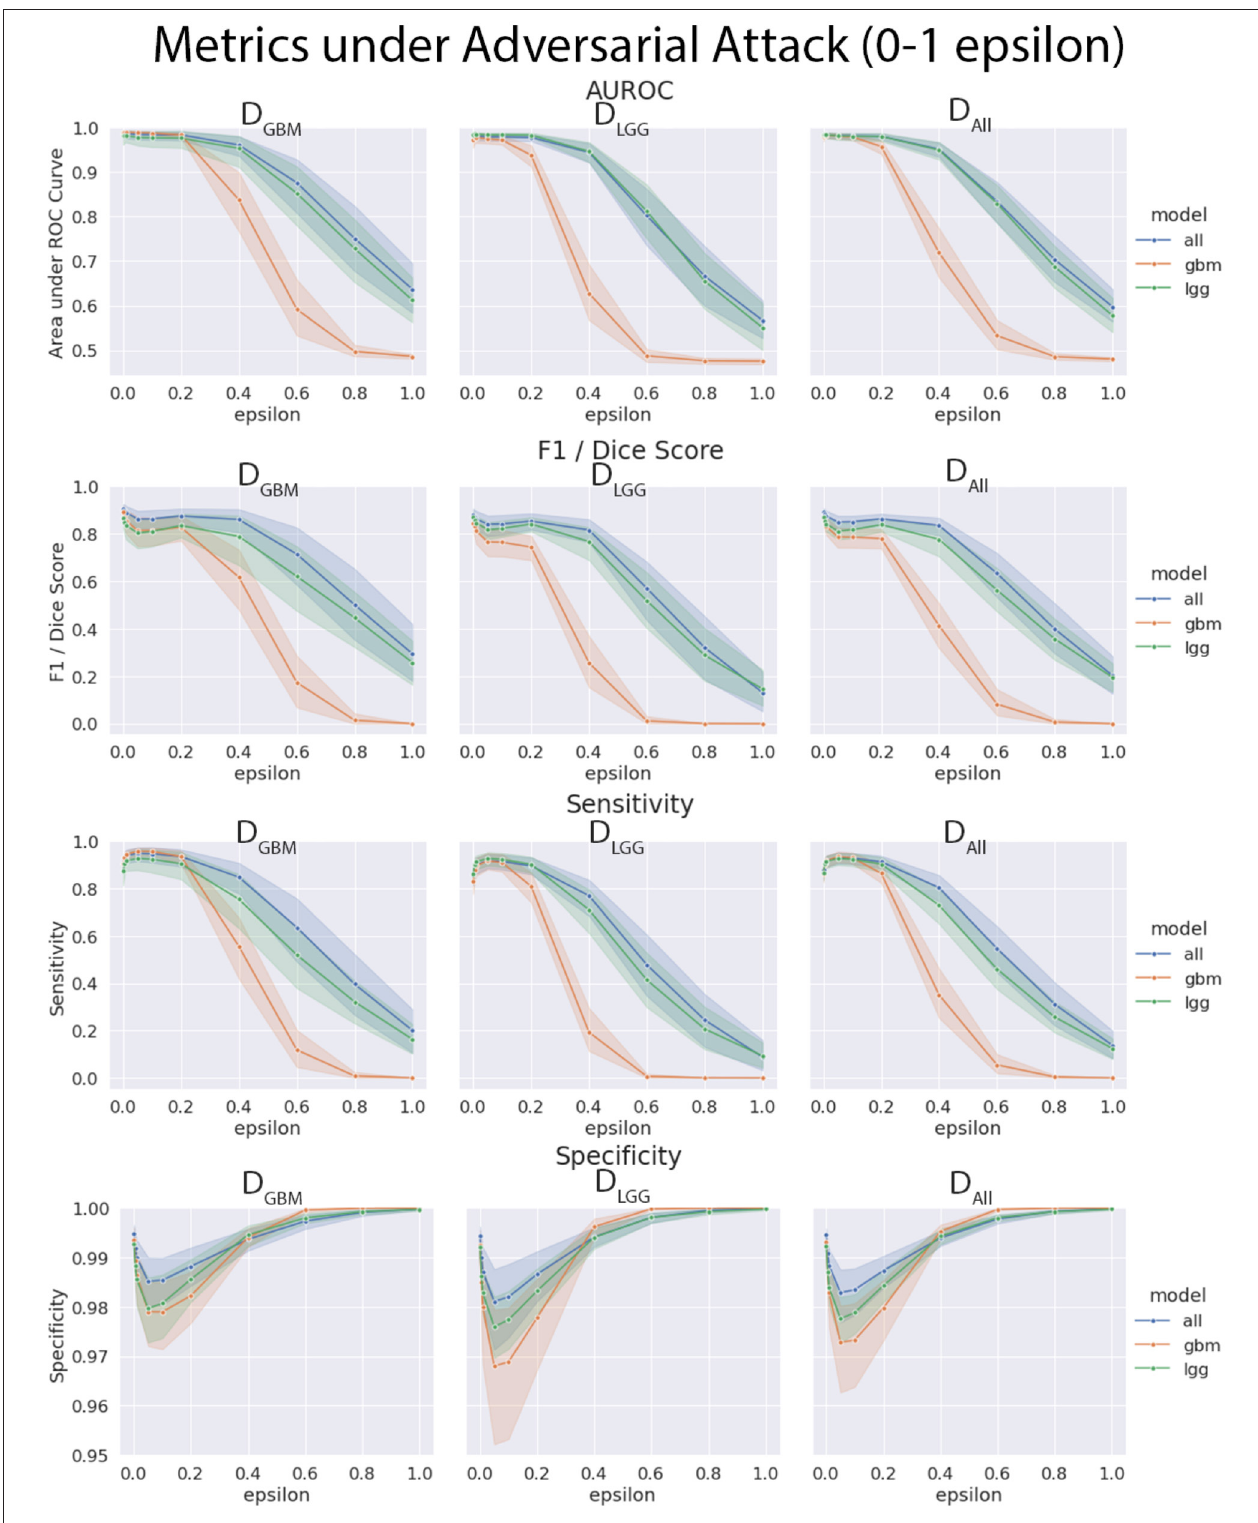
FIGURE 10 | Robustness of each model under FGSM attack, across the full range of epsilons (0–1.0) for four selected metrics. Ninety-five percent confidence intervals are provided to each model, and each of the three data sets were evaluated. M GBM was least robust to FGSM attack at higher epsilon values with regard to AUROC, Dice score, and